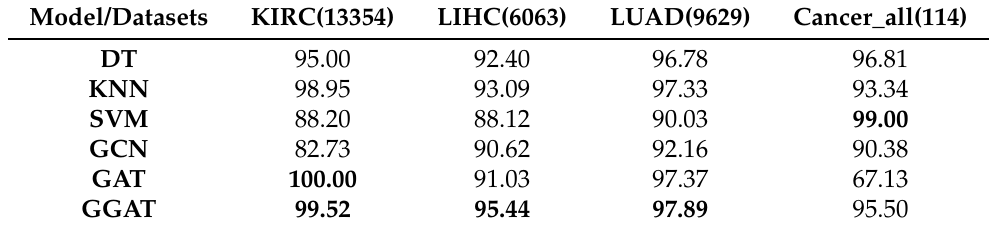
Table 7. Accuracy (%) of Models Under Original Feature Dimensions.